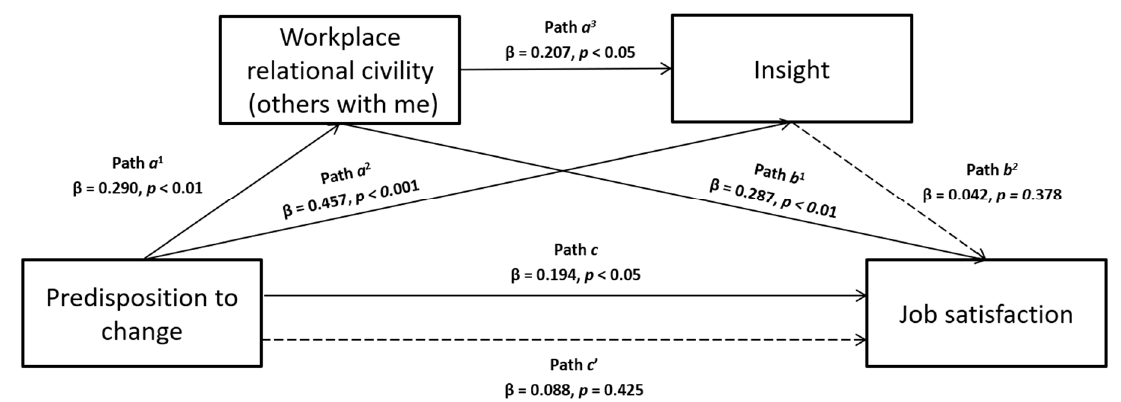
Figure 4. A serial multiple mediation model with predisposition to change as the independent variable, job satisfaction as the outcome, and both workplace relational civility (others with me) and insight as mediators, not supported by analyzes.